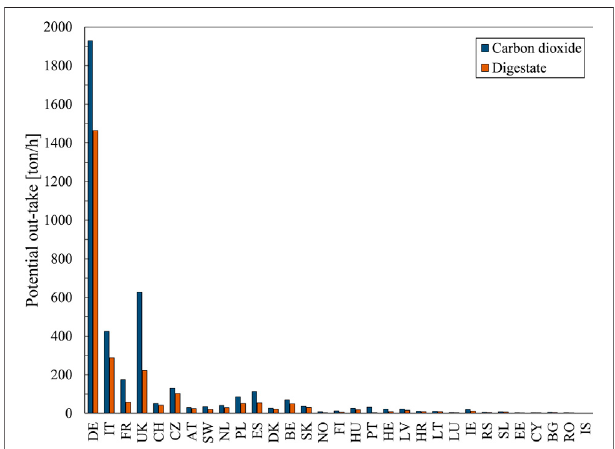
FIGURE 5 | Potential out-take of CO 2 and digestate (dry) from the operating biogas plants in Europe (end of the year 2019).